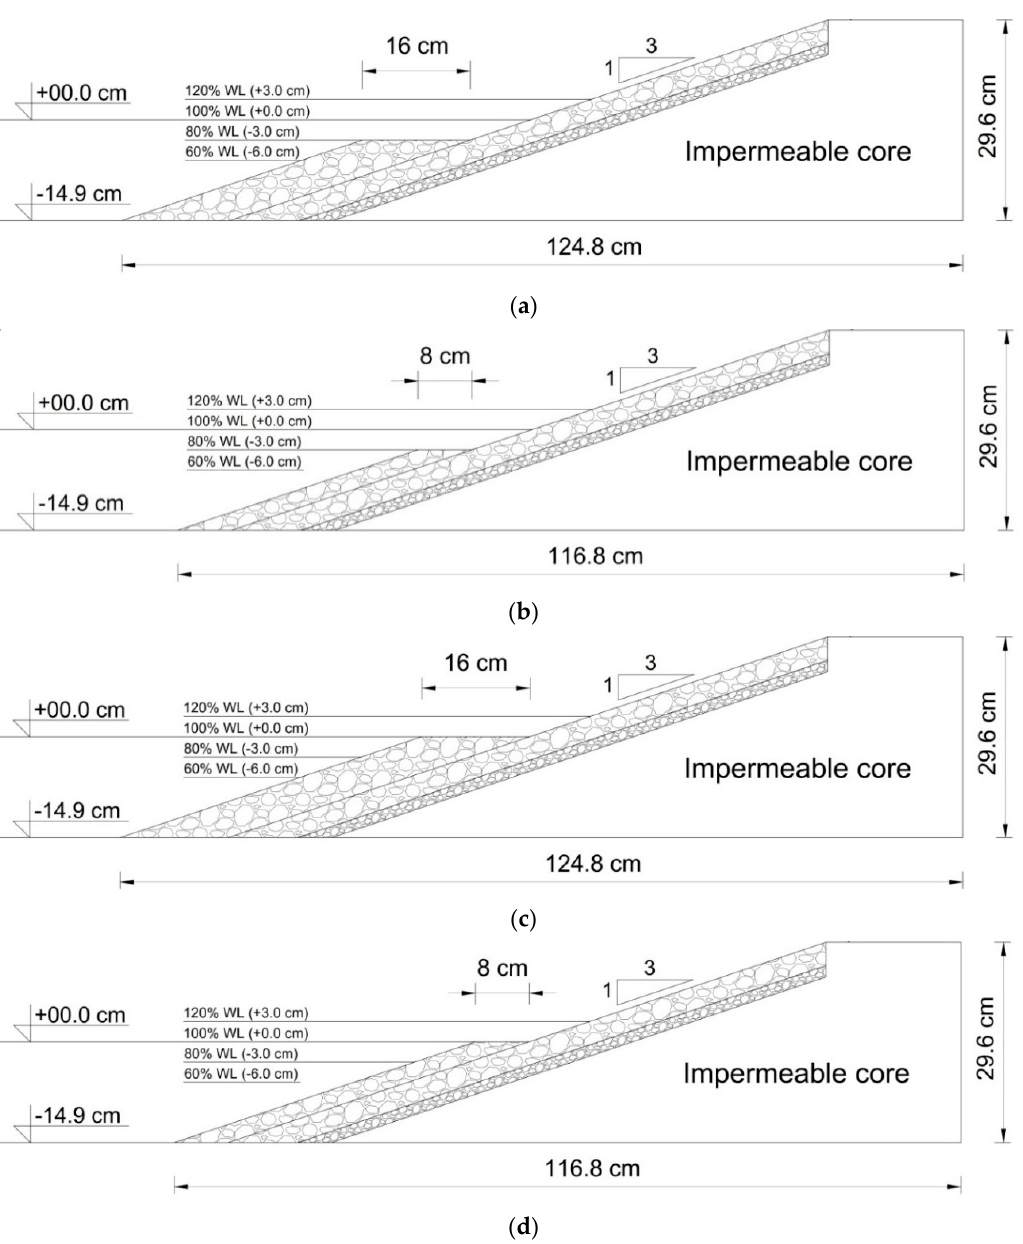
Figure 3. Structure geometries with berms ( a ): Wide berm at a level of “80% of the 100% Water level (WL)”; ( b ): Narrow berm at “80% of the 100% WL”; ( c ): Wide berm at a level of the “100% WL”; ( d ): Narrow berm at the “100% WL”).